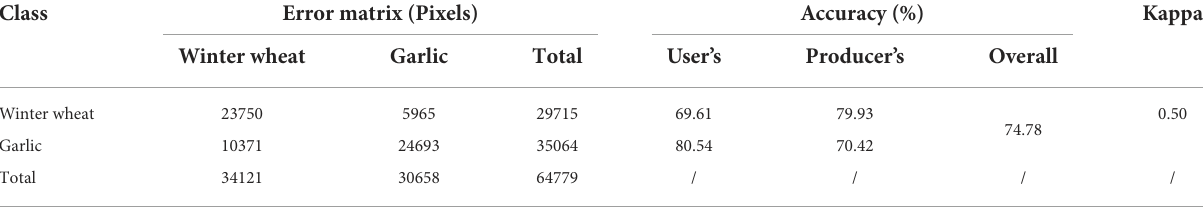
TABLE 2 Results of accuracy validation for the garlic crop based on Sentinel-2.